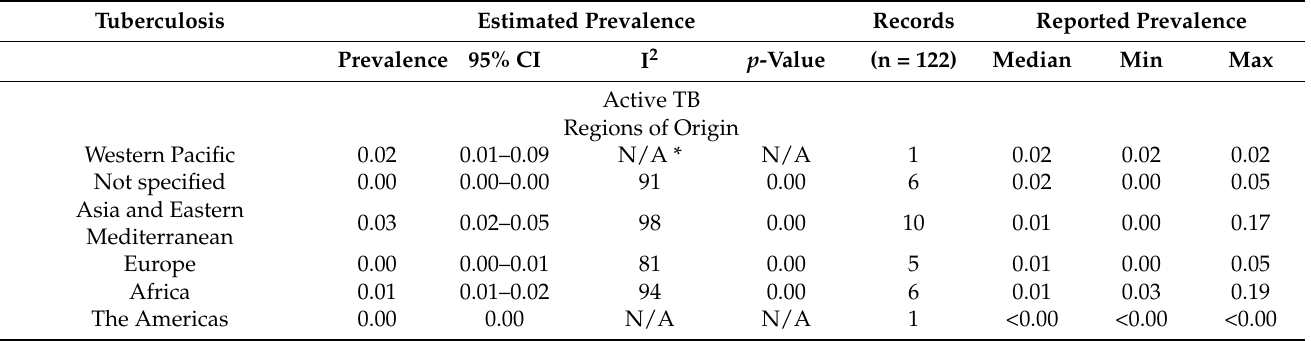
Table 3. Tuberculosis prevalence estimates, 95% confidence interval, heterogeneity level (I 2 ), p -value, records, median, minimum, and maximum reported prevalence among refugees and asylum seekers by type, regions of origins and